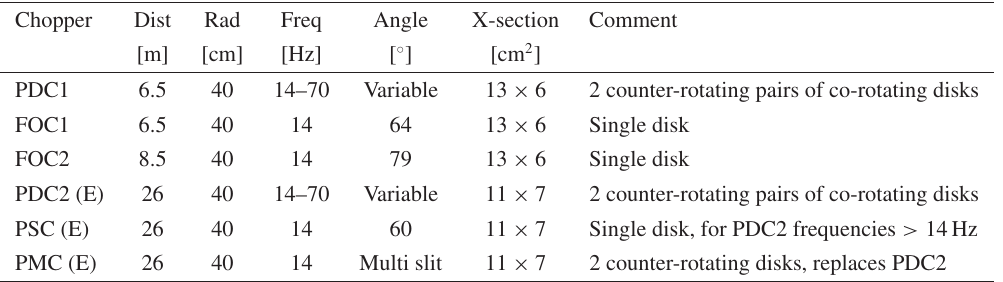
Table 2. Key parameters of the choppers. Dist: Distance from the moderator, Rad: Radius of the chopper disk (indicative). Freq: Rotation frequency range (used frequencies are multiples of 14 Hz). Angle: Opening angle of the chopper slit. X-section: Beam cross-section at the position of the chopper. Choppers are placed left or right of the beam to minimise the transition times. (E) indicates chopper disks that shall be compatible with a close-by particle physics experiment (non-depolarising, compatible with high vacuum, coated with 6 Li for low gamma